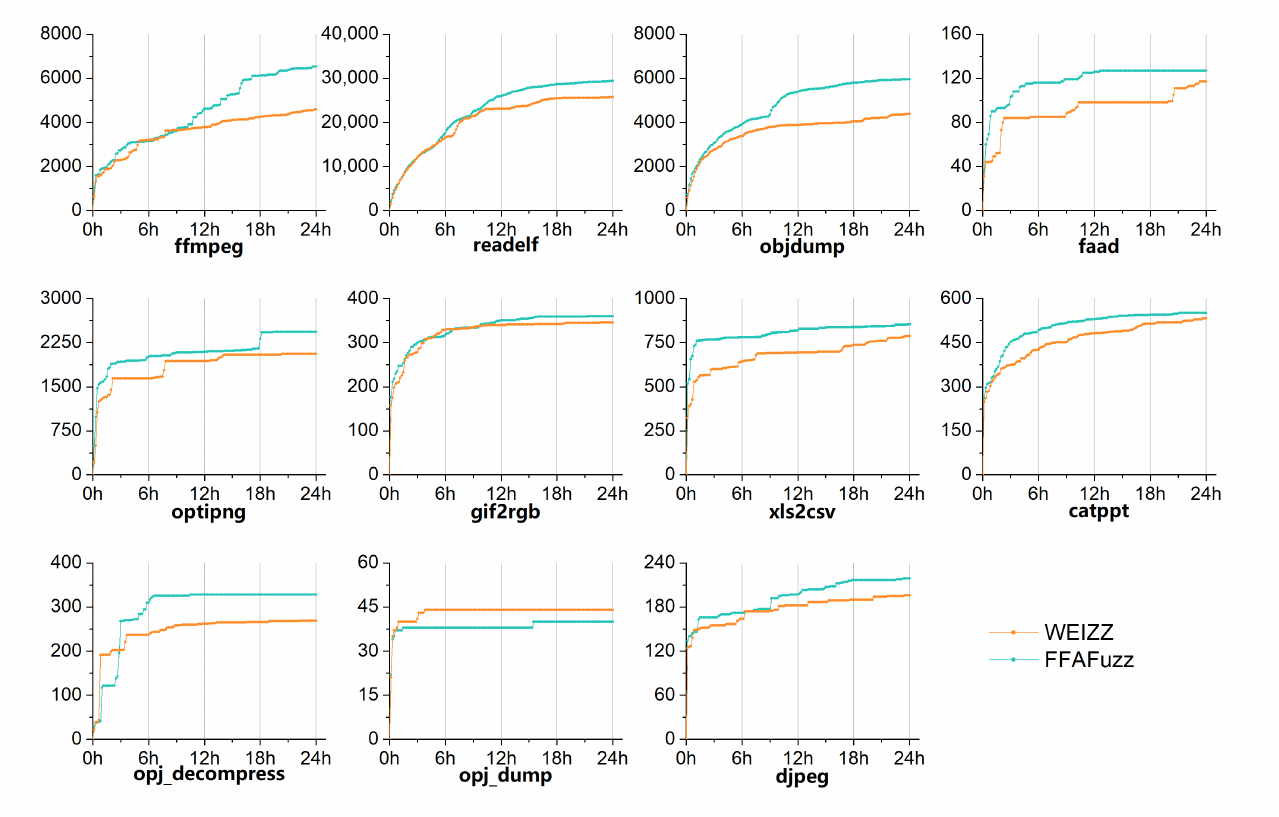
Figure 11. The number of paths discovered over the 11 targets of FFAFuzz and WEIZZ with format- well as the initial